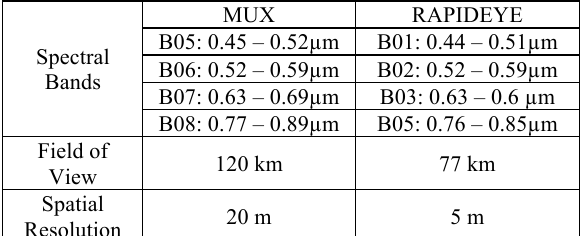
Table 1. Comparison between the MUX and RapidEye systems.